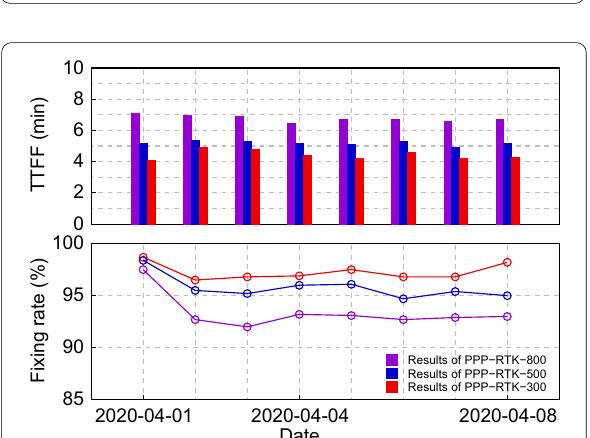
Fig. 6 Statistical results of the PPP–RTK constrained by the ionospheric delays interpolated from different scales of network